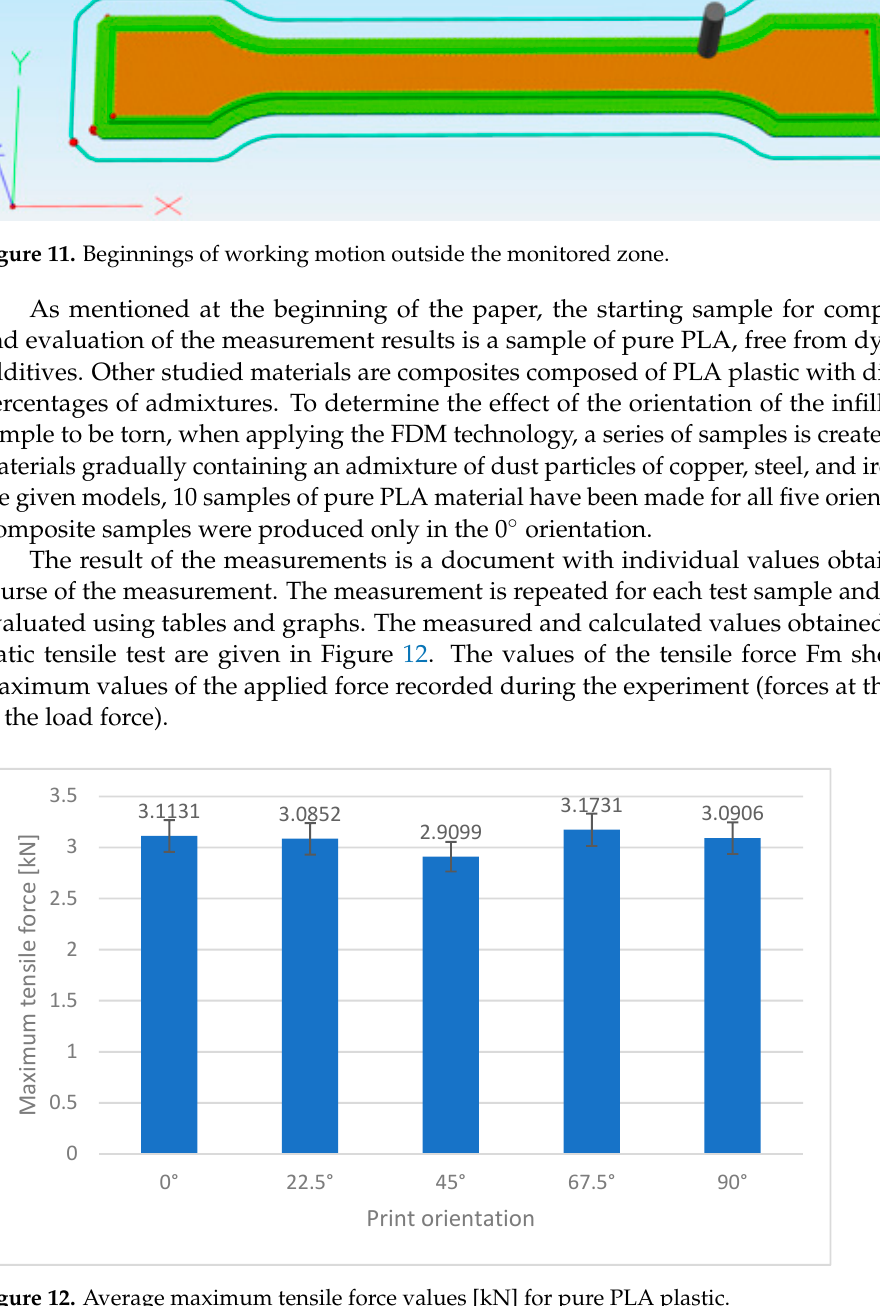
Figure 10. Test results are affected by the default starting point of the printing process.